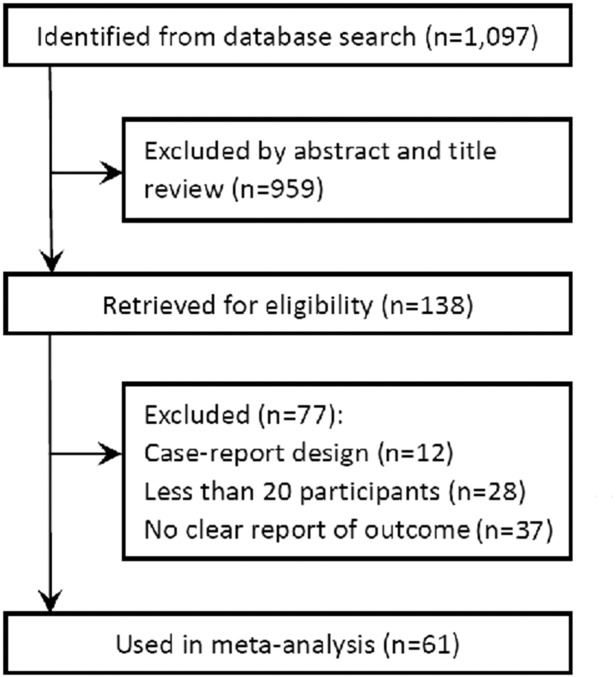
Flow chart of the study selection process.